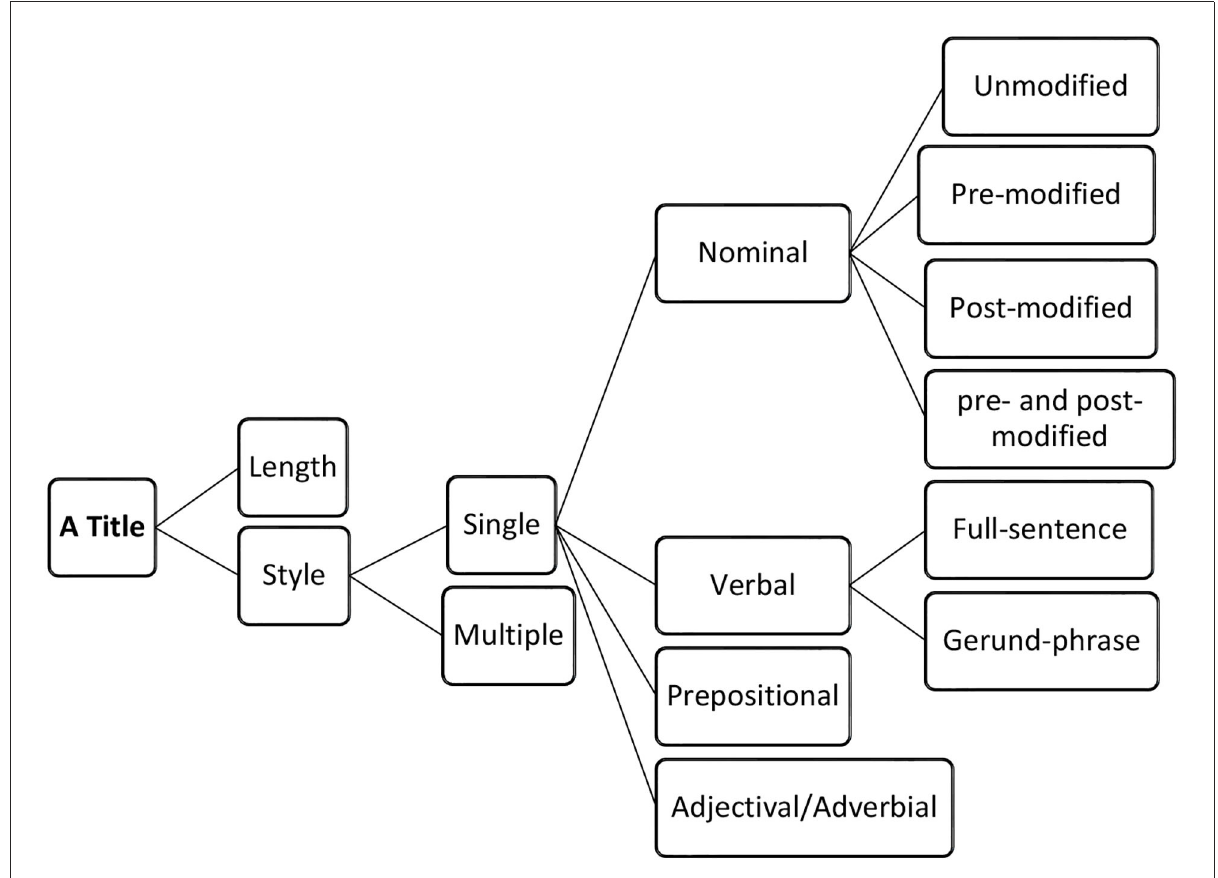
FIGURE1 A framework adapted from Dietz (1995) taxonomy to analyze syntactic structures of RA